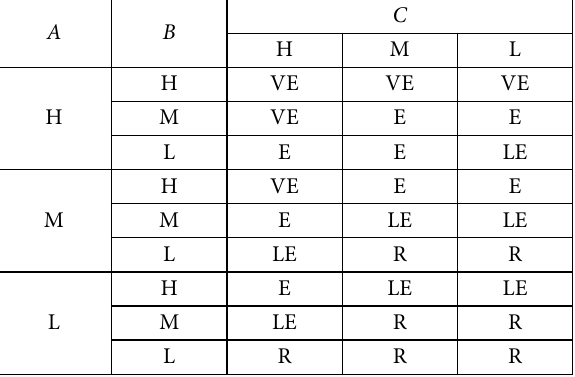
Figure 5. Membership function of each variable Table 5. Fuzzy rule